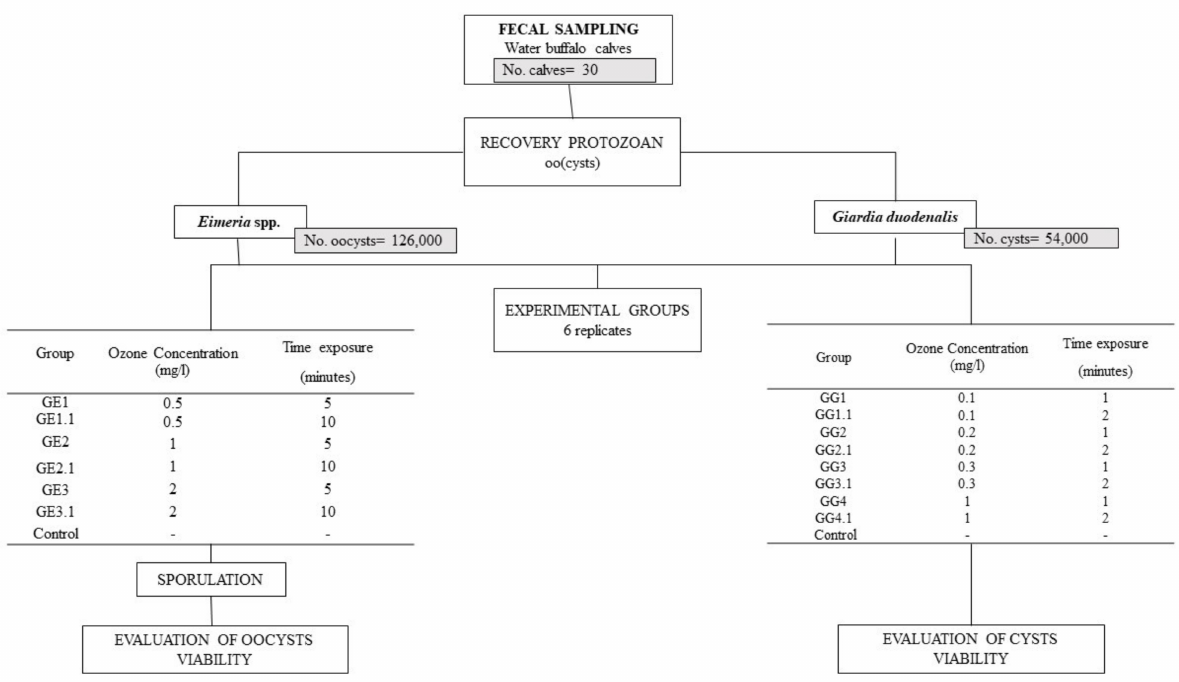
Figure 1. Study design of the in vitro effect of ozonated water treatment on the viability of Eimeria spp. oocysts and Giardia duodenalis cysts isolated from naturally infected water